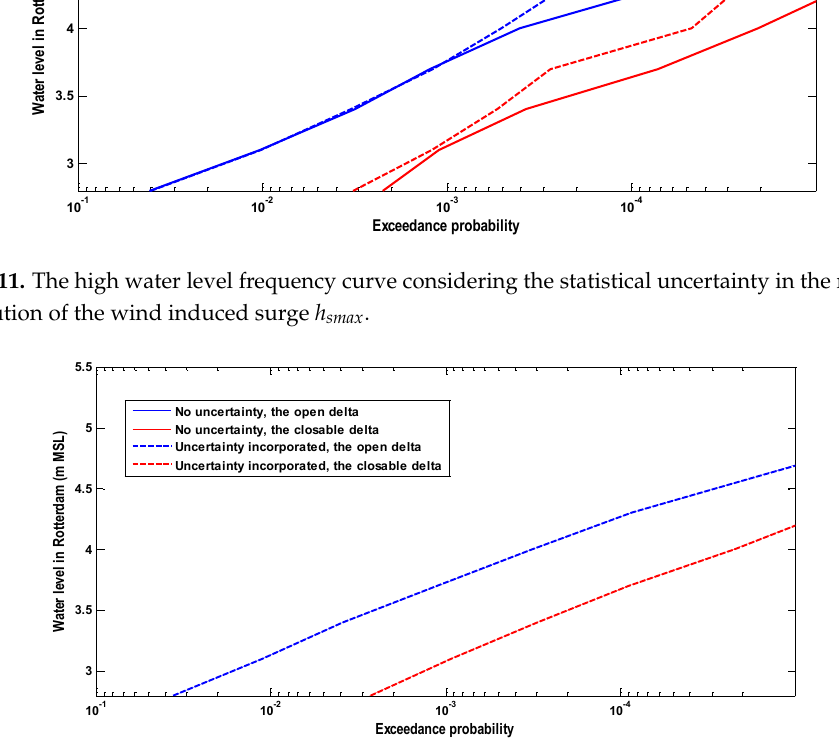
Figure 12. The high water level frequency curve considering the statistical uncertainty in the marginal distribution of the wind induced storm surge duration Ts.